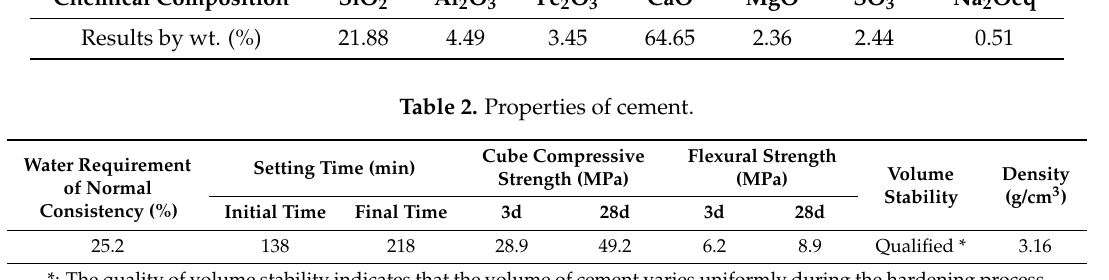
Table 2. Properties of cement.